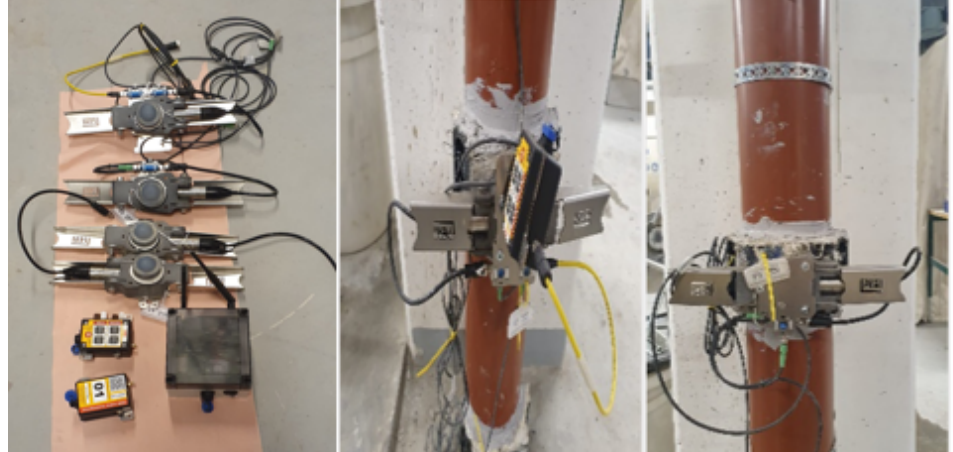
Figure 2. Pressure measuring system (the system in the left is developed by PERI).